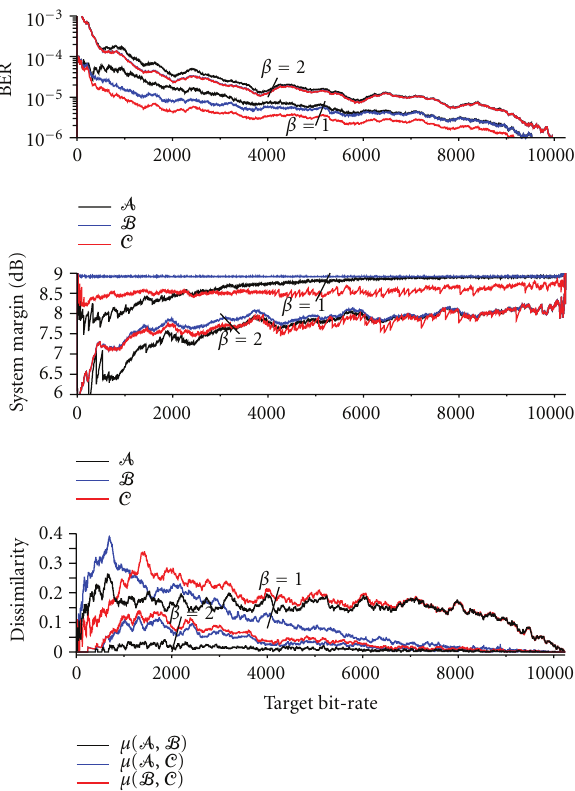
Figure 6: BER, system margin and dissimilarity versus target bitrate for Lagrangian ( A ), greedy-type system margin maximization ( B ) and greedy-type BER minimization ( C ) algorithms, n = 1024, r max = 10, and β ∈ { 1,2 }